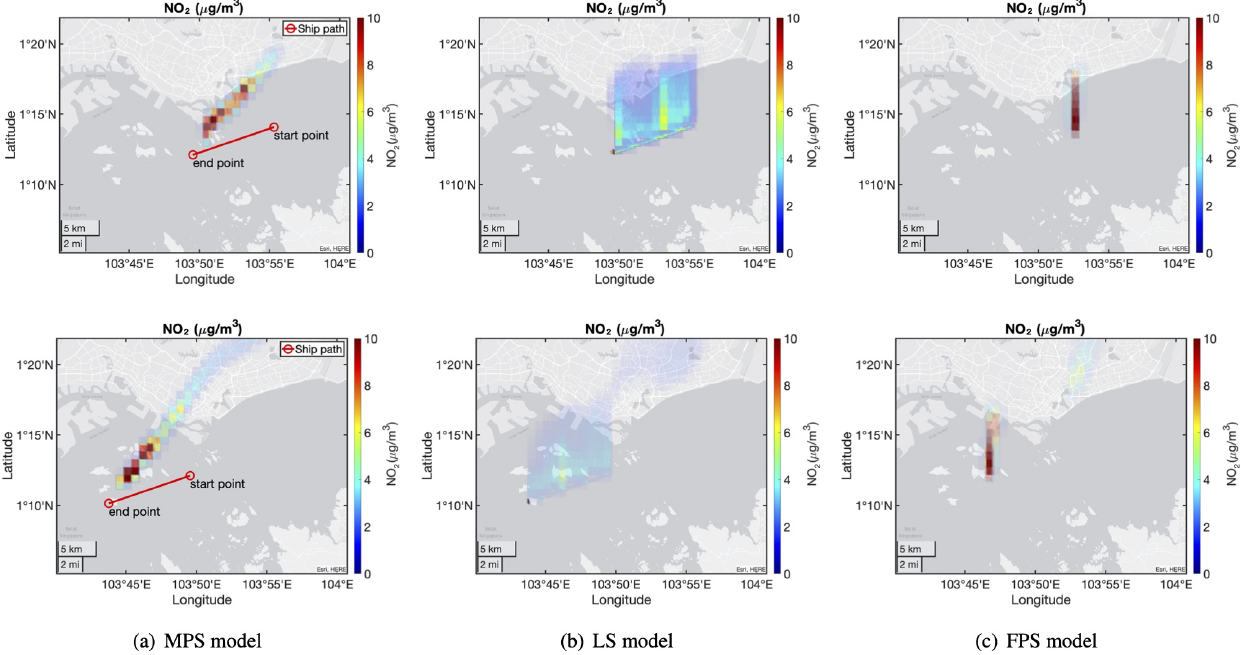
Figure 7. Instantaneous NO 2 concentrations near the ground generated by one moving ship. Top row: at t = 60min; bottom row: at t = 120min.